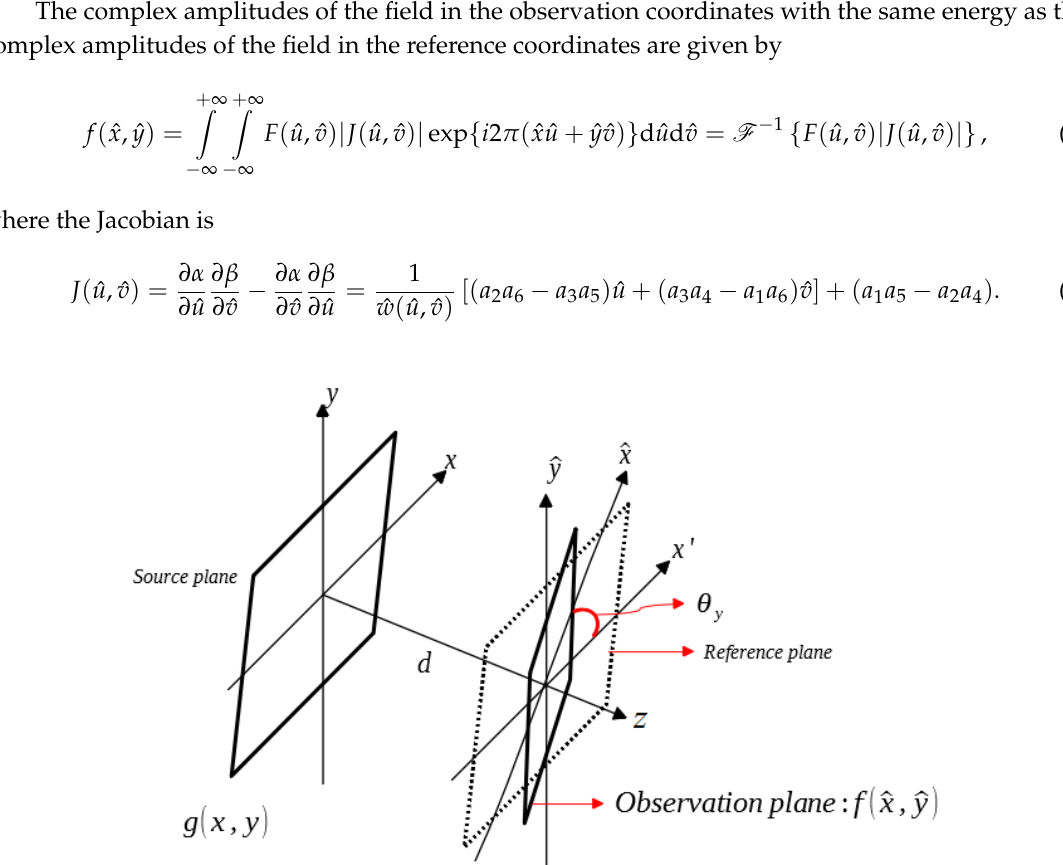
Figure 1. Optical scheme for the diffraction on a tilted plane.